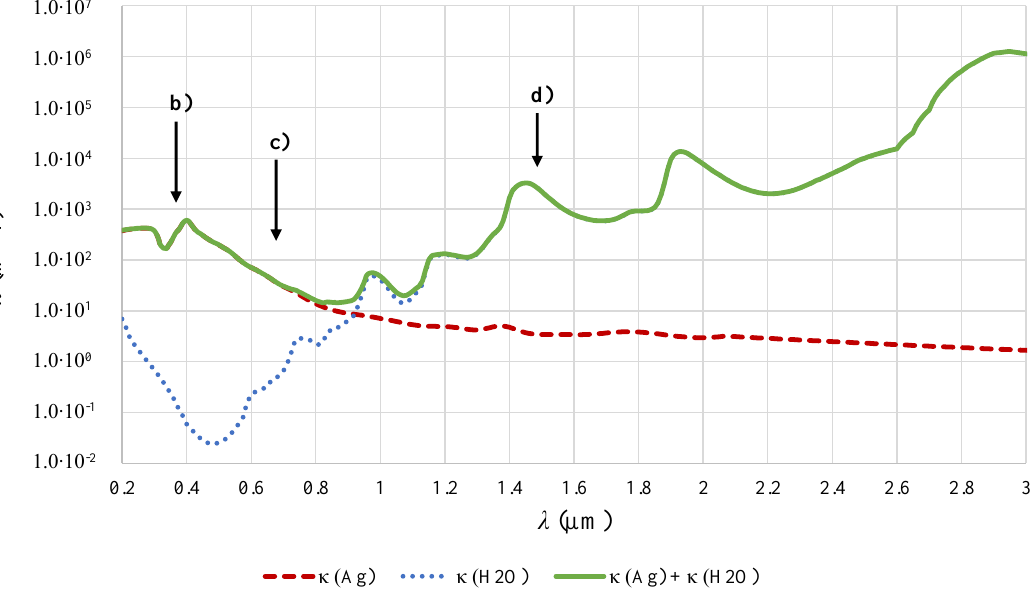
Figure 10. Absorption coefficient κ as a function of wavelength λ . Absorption by nanoparticles dominates in the UV/Vis spectral region, whereas it is almost negligible in the IR spectral range where the influence of the base fluid